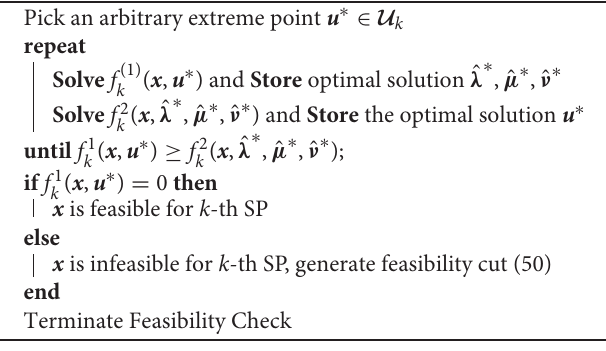
Algorithm 1: Feasibility Check for k -th